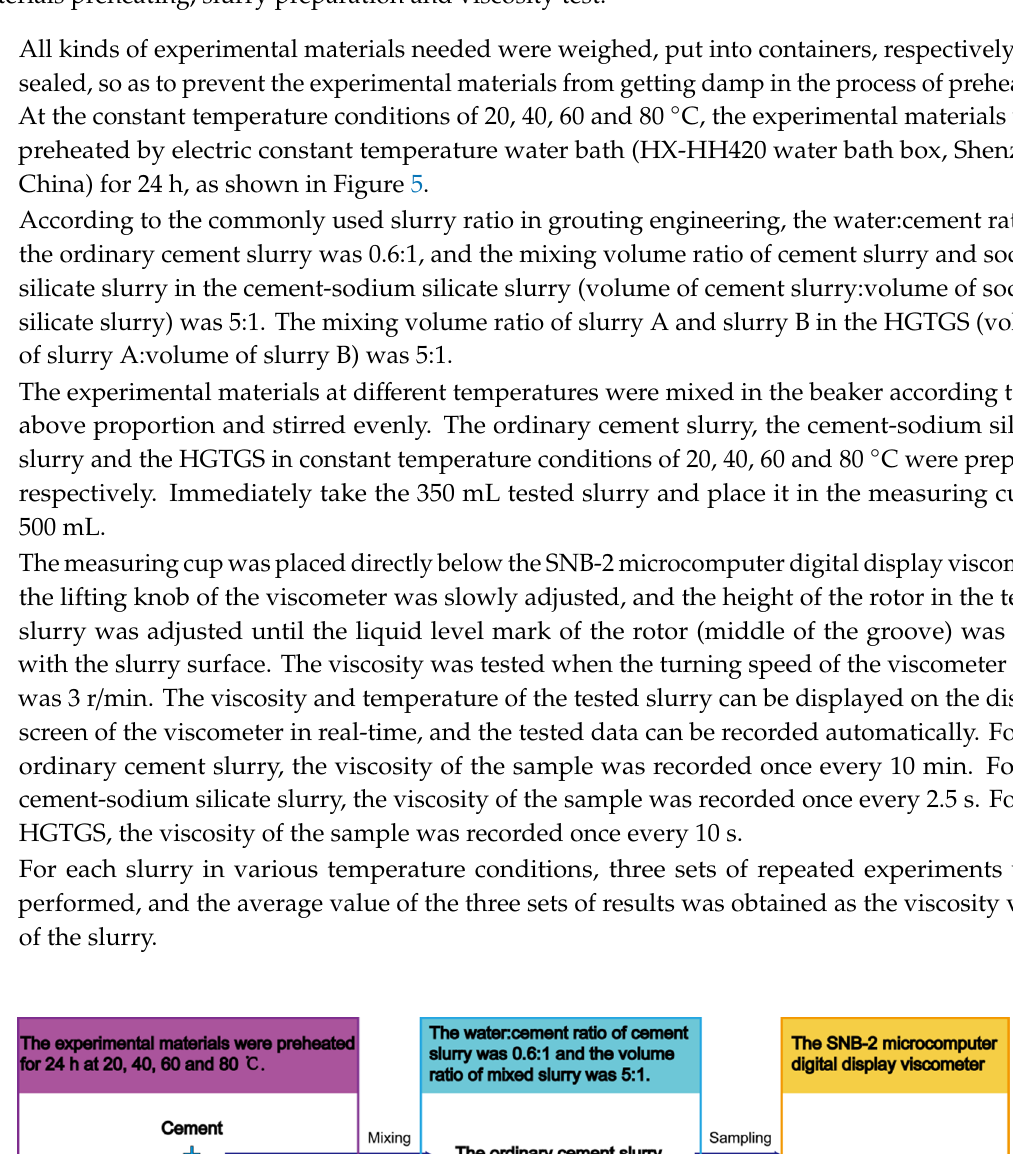
Figure 3. The SNB-2 microcomputer digital display viscometer.